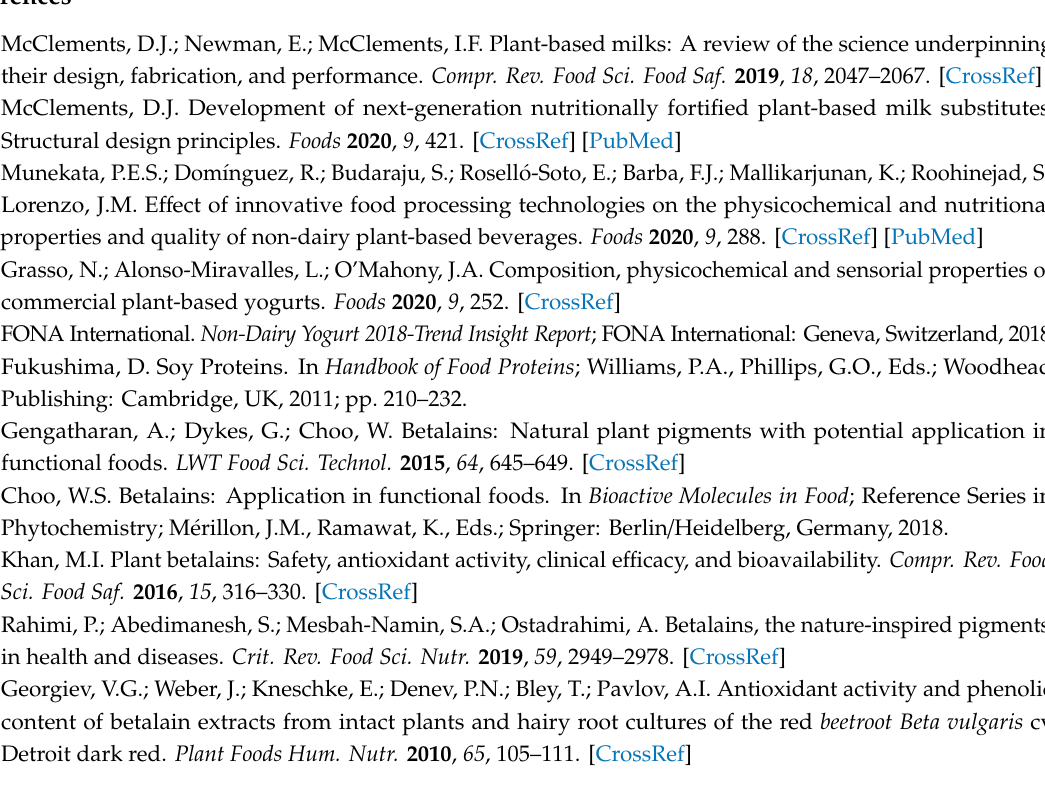
Table S1: Variations in color index of soy-based yogurt alternative during 21 days of storage. Soy-based yogurt alternative – SY; B – Red beetroot; O – Opuntia; H - Hibicus; R - Red radish; Ei - Ethanolic injection method; Fh - thin film hydration method. Amounts of extracts (mg) are given in